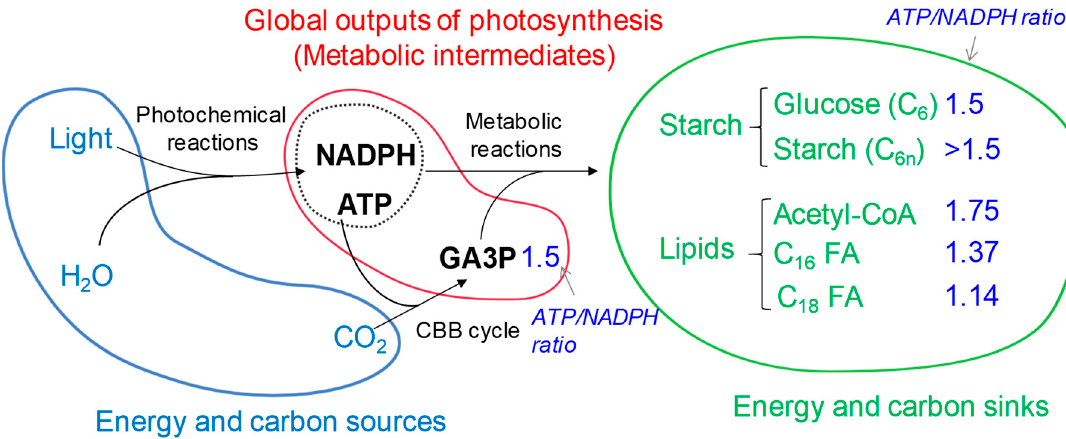
Figure 1. Source and sink relationships in a photoautotrophically grown algal cell. A simple flow is drawn here, but it should bear in mind that catabolisms of «sink» compounds could influence the flux or repartition of «metabolic intermediates». Note: the blue numbers, taken from [2], denote the ratio of ATP / NADPH needed for the production of respective molecules. Abbreviations: ATP, adenosine triphosphate; CBB, Calvin-Benson Bassham; CoA, coenzyme A; FA, fatty acid; GA3P, glyceraldehyde-3-phosphate; NAD(P)H, nicotinamide adenine dinucleotide (phosphate).